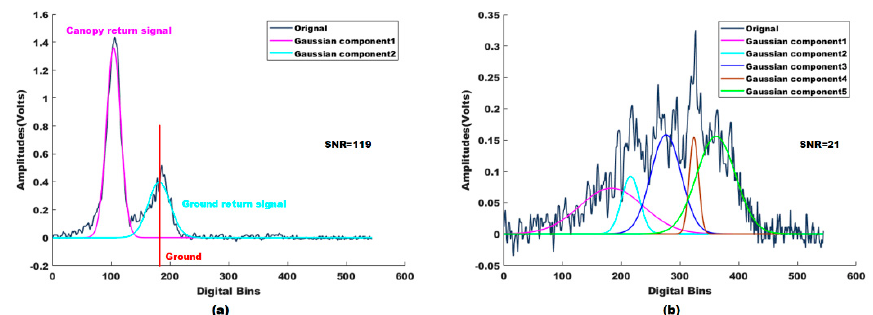
Figure 9. Two typical GLAS received waveforms with different SNR values. ( a ) is a received waveform with a high SNR value. Gaussian component 1 is the canopy return signal, Gaussian component 2 is the ground signal, and the red line marks the position of the ground. ( b ) is the received waveform with a low SNR value. It can be noted that it is hard to recognize useful information from the decomposed Gaussian components.